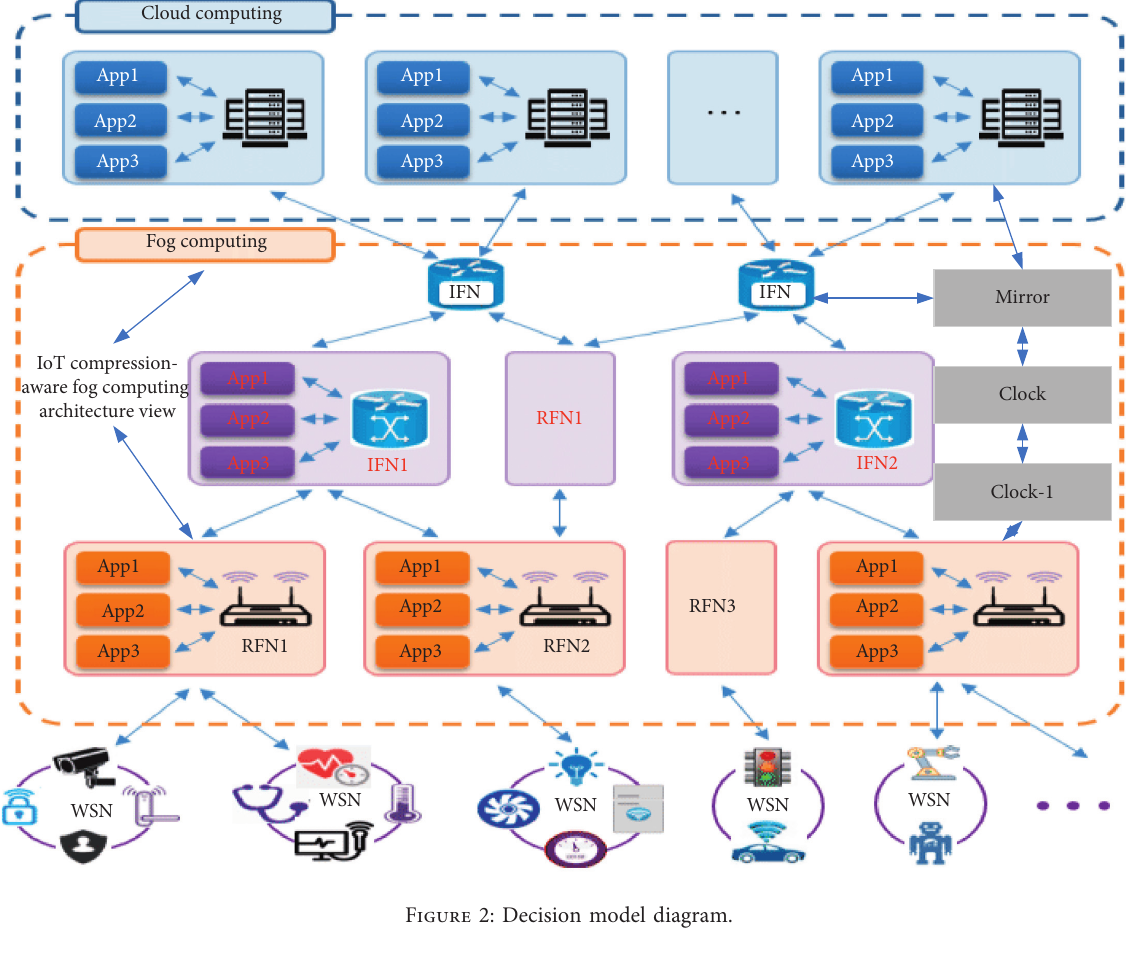
Figure 2: Decision model diagram.